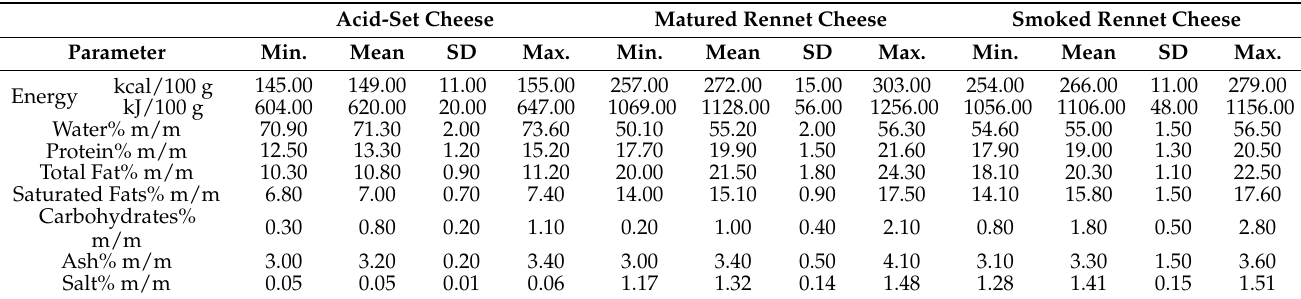
Table 4. Goat’s milk cheeses’ physicochemical